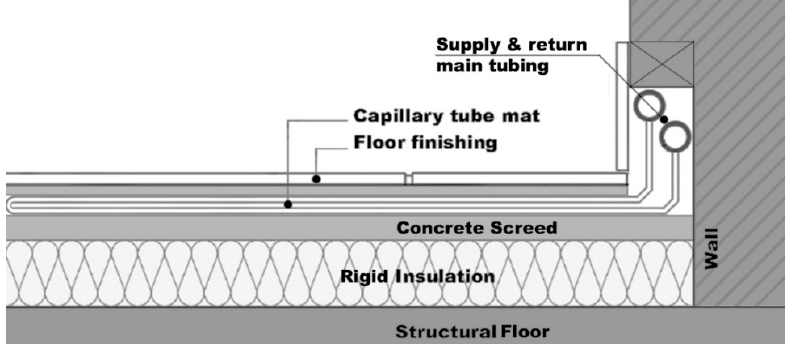
Figure 10. Capillary tube radiant floor. Source: BEKA Klima-Komfort, redrawn by the first author.